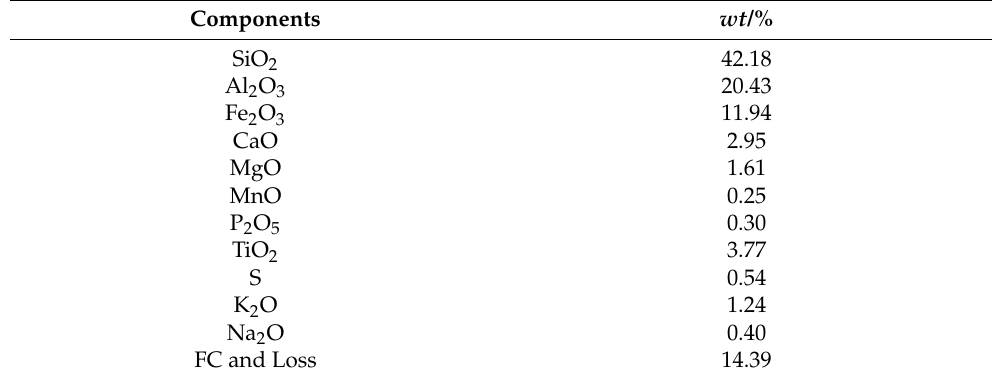
Table 1. Main components of the coal